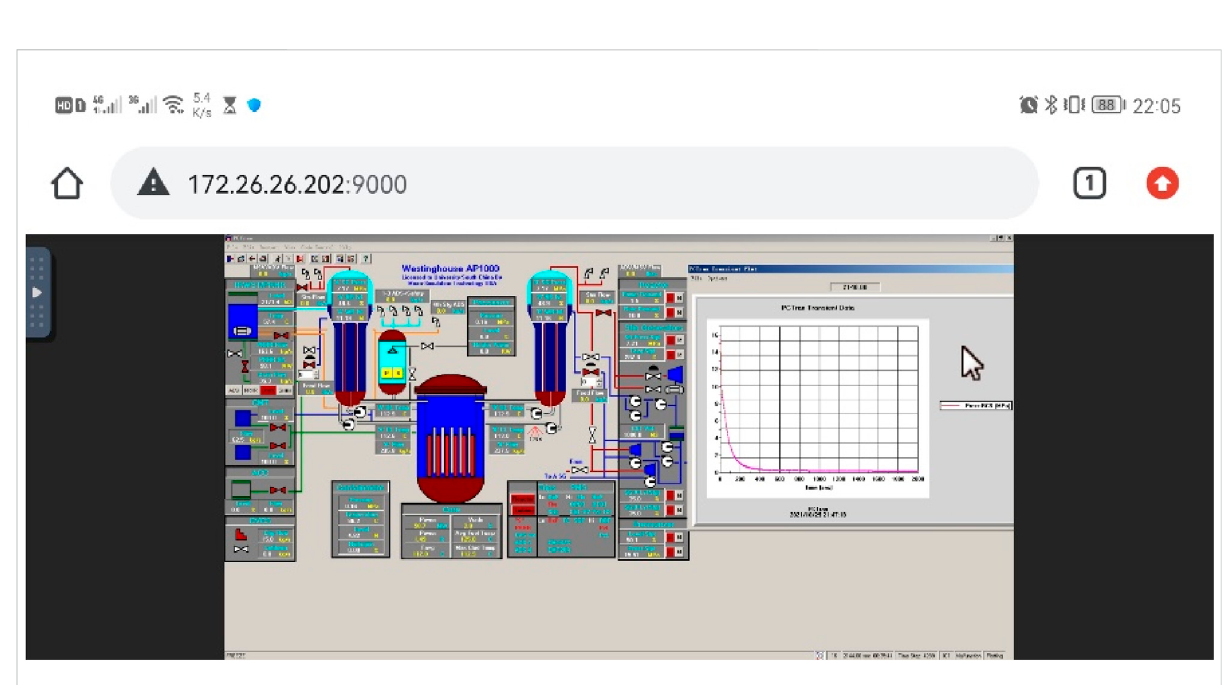
Operation of the chrome on the mobile phone.